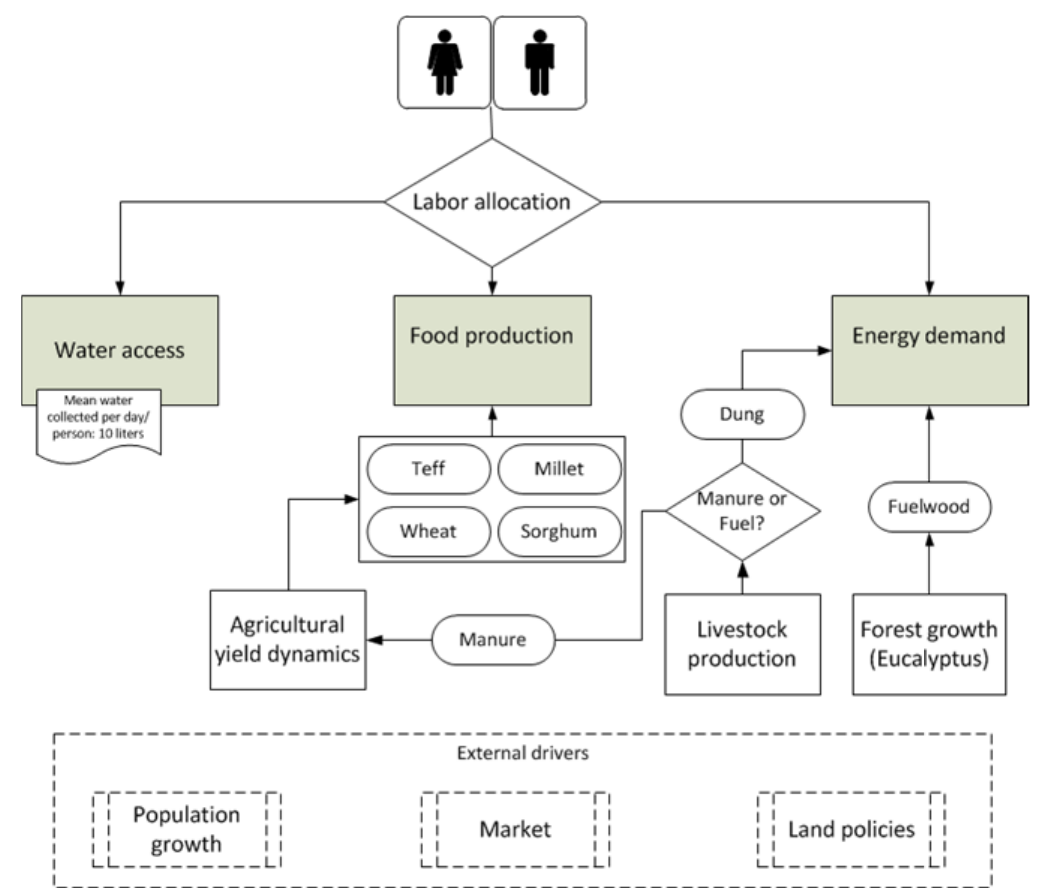
Figure 1. Household-level conceptual model based on a participatory approach (modified from